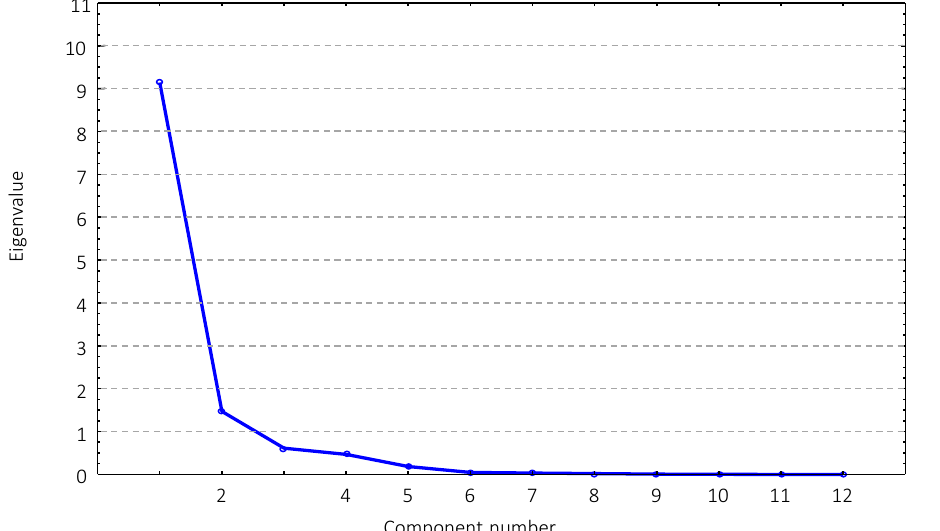
Figure 5. Graph of eigenvalues of components according to the scree plot